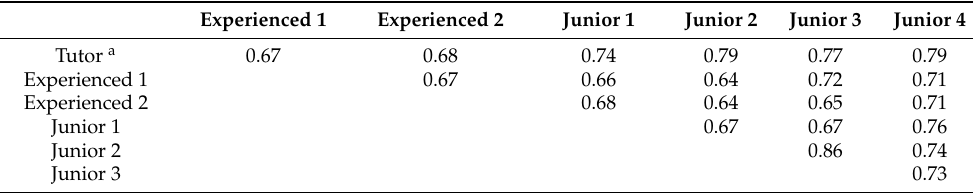
Table 2. Inter-rater and intra-rater agreements of the Forrest classification.